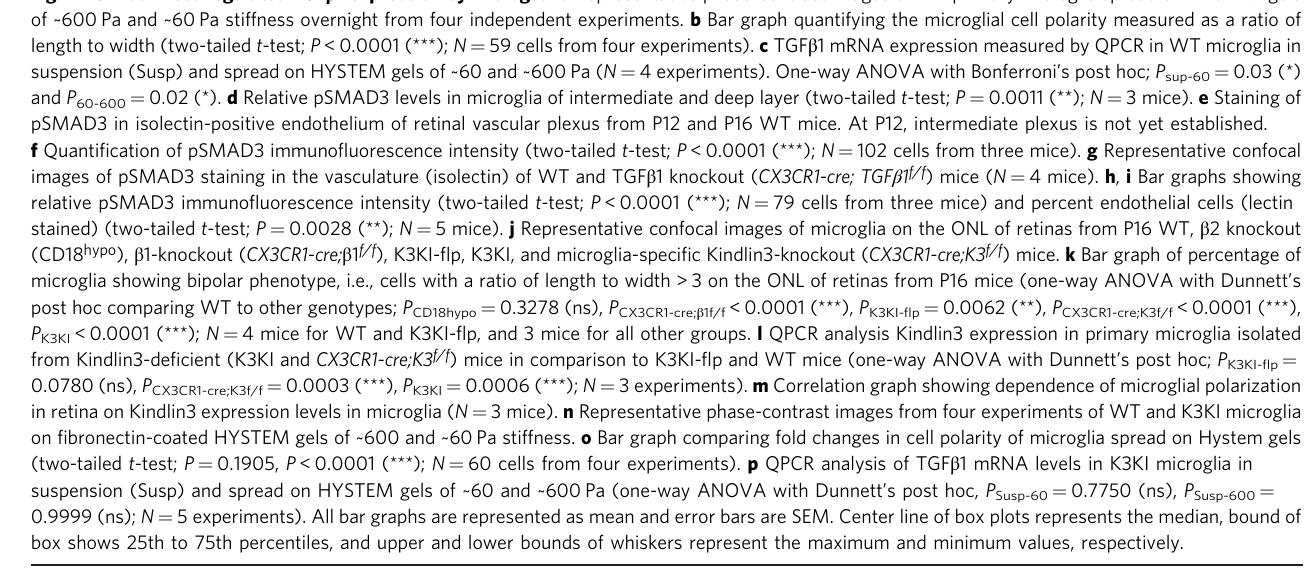
Fig. 2 ECM stiffness regulates TGF β 1 expression by microglia. a Representative phase-contrast images of WT primary microglia spread on HYSTEM gels of ~600 Pa and ~60 Pa stiffness overnight from four independent experiments. b Bar graph quantifying the microglial cell polarity measured as a ratio of length to width (two-tailed t -test; P < 0.0001 (***); N = 59 cells from four experiments). c TGF β 1 mRNA expression measured by QPCR in WT microglia in suspension (Susp) and spread on HYSTEM gels of ~60 and ~600 Pa ( N = 4 experiments). One-way ANOVA with Bonferroni ’ s post hoc; P sup-60 = 0.03 (*) and P 60-600 = 0.02 (*). d Relative pSMAD3 levels in microglia of intermediate and deep layer (two-tailed t -test; P = 0.0011 (**); N = 3 mice). e Staining of pSMAD3 in isolectin-positive endothelium of retinal vascular plexus from P12 and P16 WT mice. At P12, intermediate plexus is not yet established. f Quanti fi cation of pSMAD3 immuno fl uorescence intensity (two-tailed t -test; P < 0.0001 (***); N = 102 cells from three mice). g Representative confocal images of pSMAD3 staining in the vasculature (isolectin) of WT and TGF β 1 knockout ( CX3CR1-cre; TGF β 1 f/f ) mice ( N = 4 mice). h , i Bar graphs